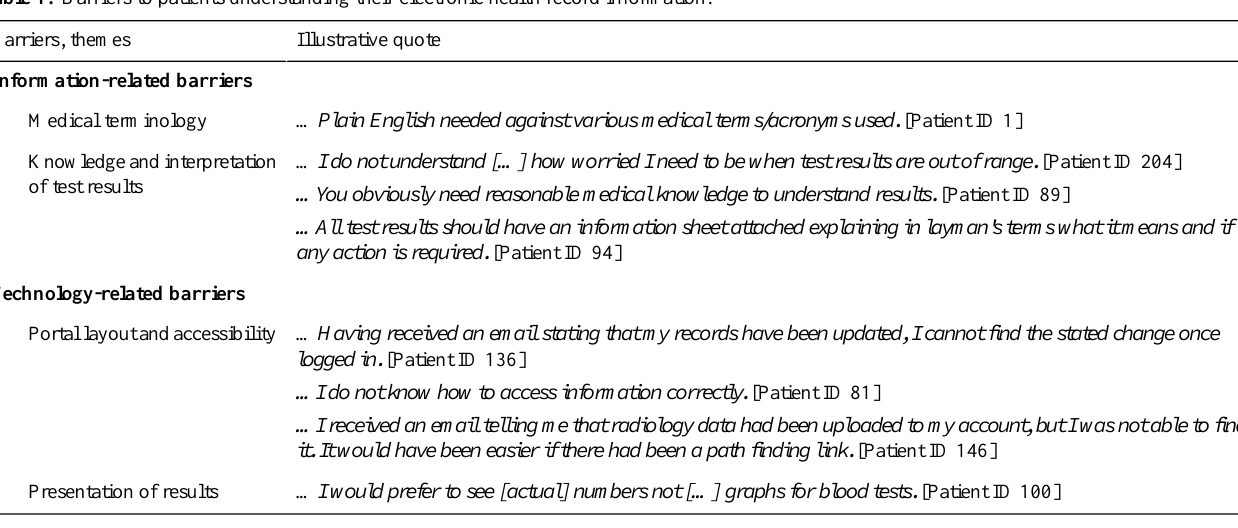
Table 1. Barriers to patients understanding their electronic health record information.